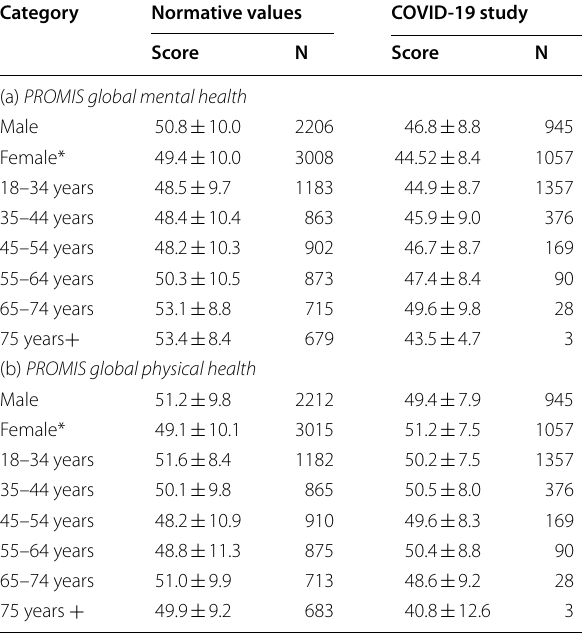
Table 4 Normative values for the US general population for the PROMIS Global Health